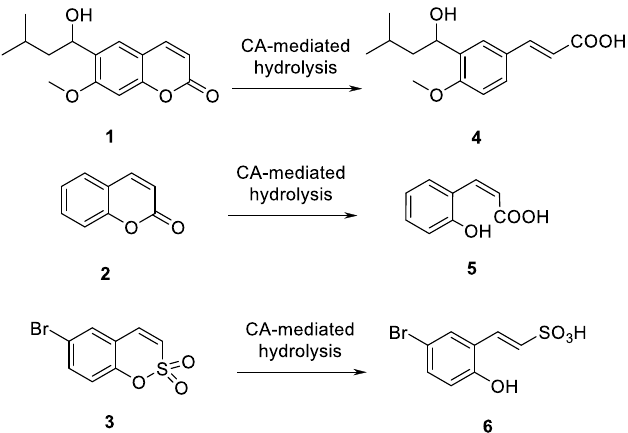
Figure 1. Coumarins 1 and 2, and sulfocoumarin 3 and their CA-mediated hydrolysis to the CAI active species 4 , 5 and 6 , respectively.